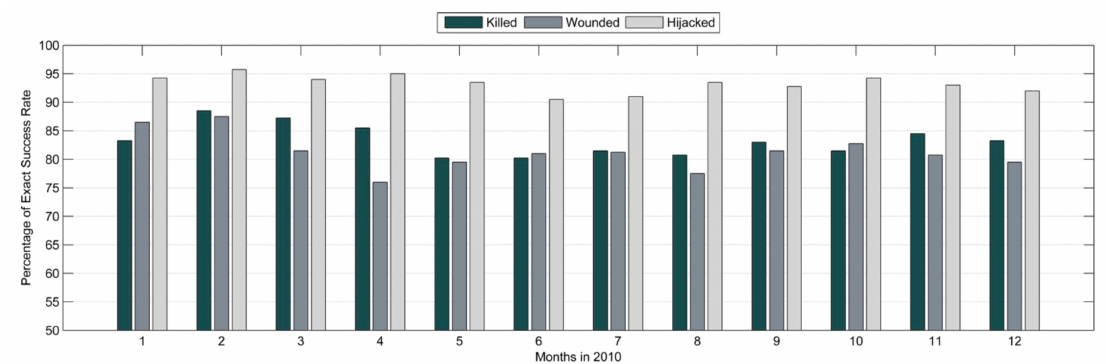
Figure 5. Percentage of exact success rate per month in 2010.